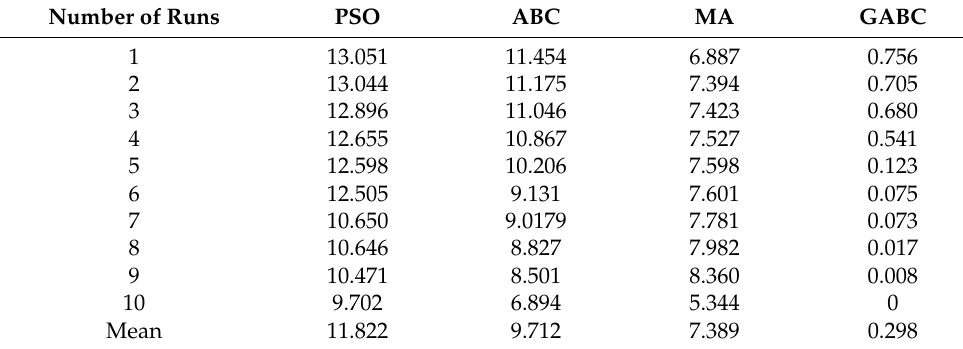
Table 11. RPI values obtained by different algorithms.